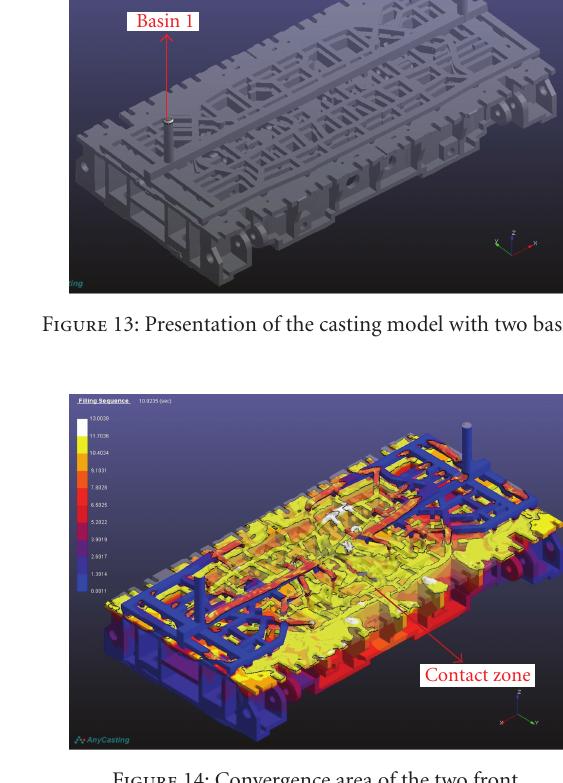
Figure 14: Convergence area of the two